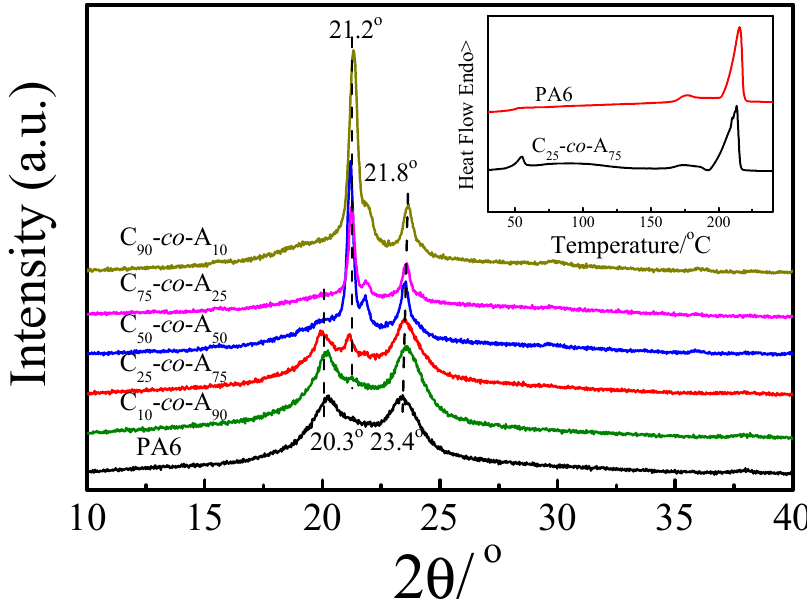
Figure 6. Wide-angle X-ray diffraction (WAXD) patterns of PA6 and P(CLA- co -CLO) copolymers after isothermal crystallization firstly at 160 °C for 2 h and then at 40 °C. The insert is the DSC melting curves of PA6 and C 25 -co- A 75 with the same thermal history as the WAXD experiments. (The heating rate is 10 °C/min).